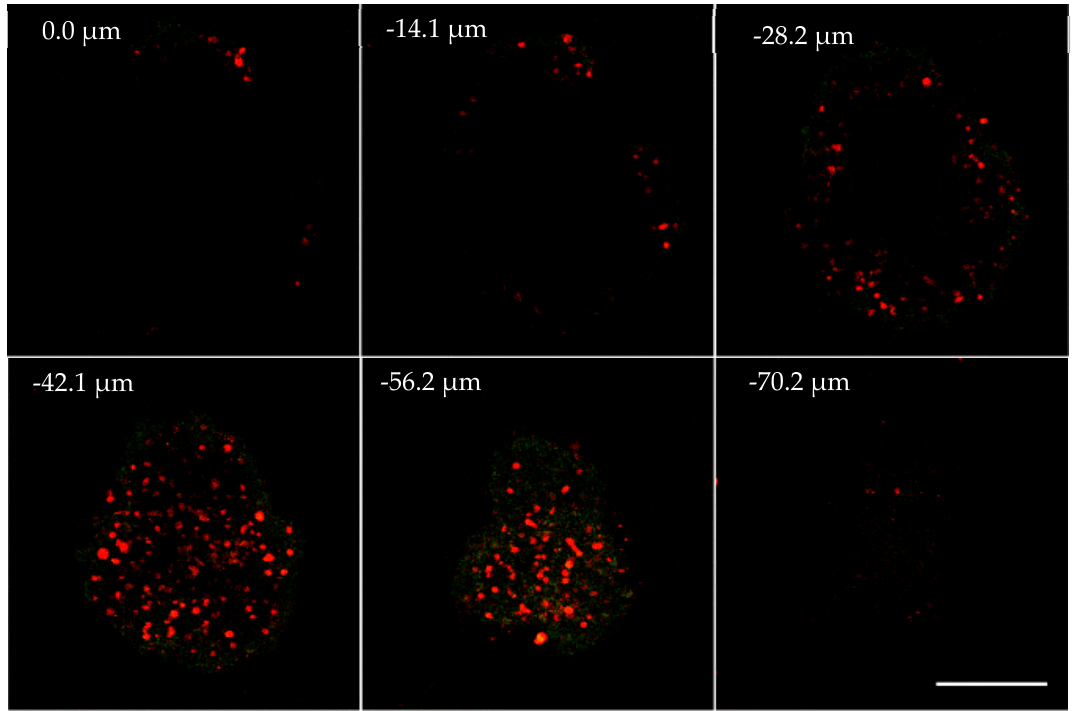
Figure 7. Z-stack of two-photon microscopy images of MCTs. The images were taken every 14.04 µ m section from the top to bottom of intact MCTs. The green and red channel was collected at 525–565 nm and 585–625 nm, respectively. The scale bar = 200 µ m.